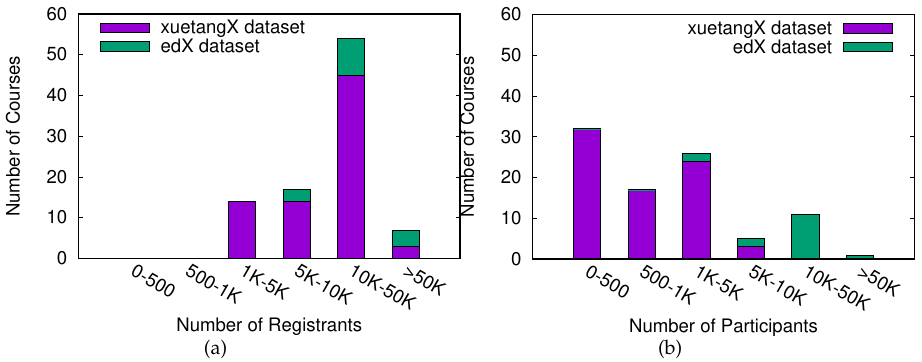
Figure 1. Registrants and participants distribution: ( a ) Registrants distribution; ( b ) Participants